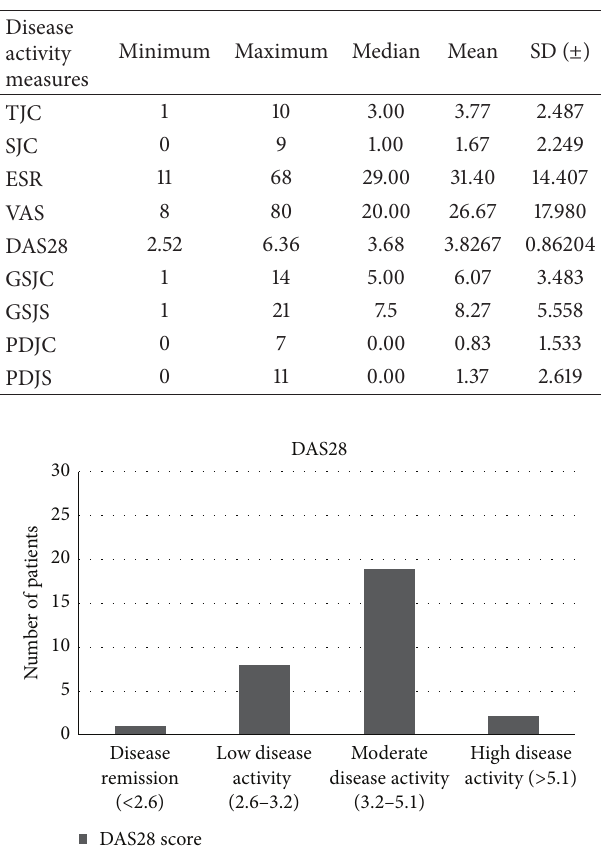
Table 3: Range of clinical and ultrasound measures of synovial disease.